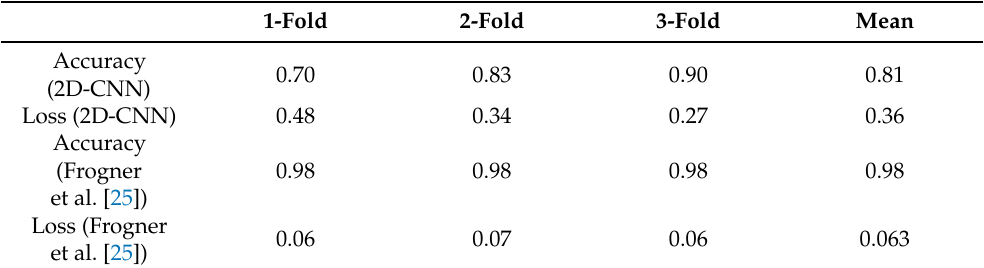
Table 3. Loss and accuracy of 3-fold cross-validation obtained in previous works and our pro- posed work. 1-Fold 2-Fold 3-Fold